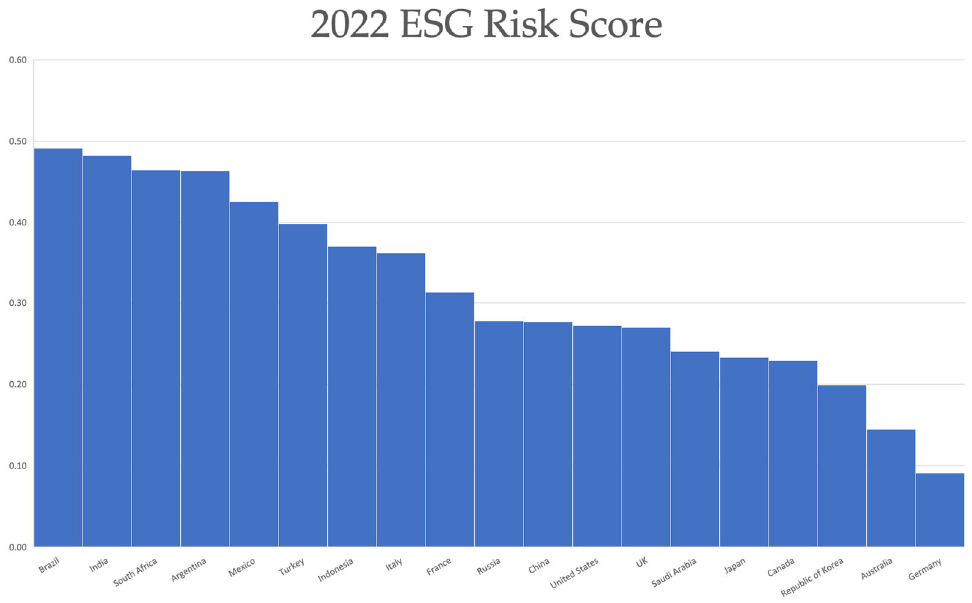
Figure 2. 2022 ESG Risk Score. Note: Source: https://countryrisk.io. Table 4 represents the ESG risk score before a systemic banking crisis, t represents the year of the crisis, and t − 1 represents one year before the crisis. Since our model predicts whether a systemic banking crisis will occur in the fifth year based on the data of the previous four years, the number of crises actually predicted will be less than that in Table 1. Table 4. ESG Risk Score Before Systemic Banking Crisis.